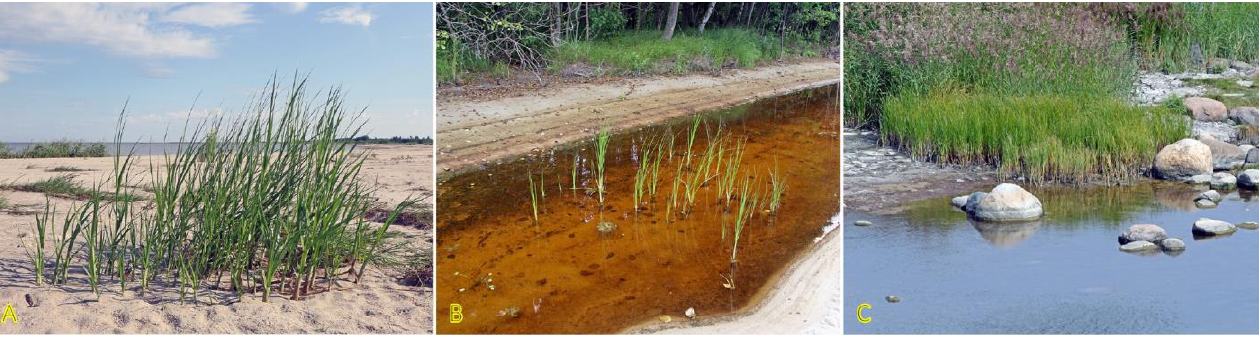
Figure 8. Bolboschoenus maritimus on a wet sandy beach in Ainaži, Latvia ( A ), on a wet sandy beach in Melnsils, Latvia ( B ), on a pebble beach on the island of Kihnu, Estonia ( C ).